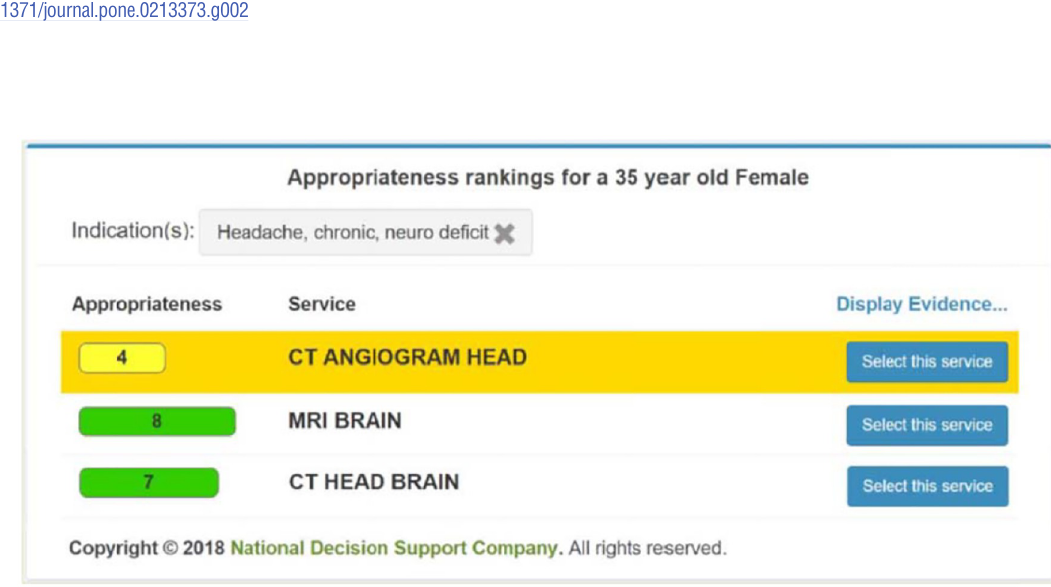
PLOS ONE | https://doi.org/10.1371/journal.pone.0213373 March 15,